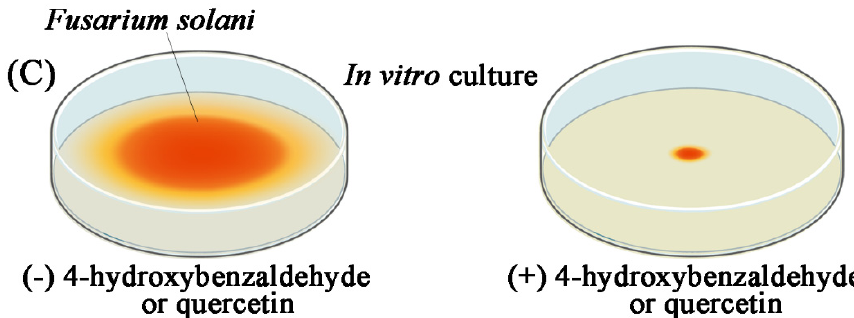
Figure 8. Mechanism diagram of GRE antifungal activity against F. solani. ( A ) In vitro antifungal activities of GRE against F. solani. Briefly, the colony diameter and spores’ germination were signifi- cantly decreased, and hypha were ruptured. ( B ) The physiological changes of F. solani responded to GRE treatment. Generally, GRE decreased the cell membrane integrity of F. solani, which further increased relative conductivity of the fungal cell, and decreased soluble protein and sugar content. Meanwhile, the cell wall-degrading enzyme activities (pectinase and β -glucosidase), key enzymes in energy metabolism (MDH and SDH), and fusaric acid content were severely affected by GRE. ( C ) In vitro antifungal activities of 4-hydroxybenzaldehyde and quercetin against F. solani. Colony di- ameter was significantly decreased by 4-hydroxybenzaldehyde and quercetin.